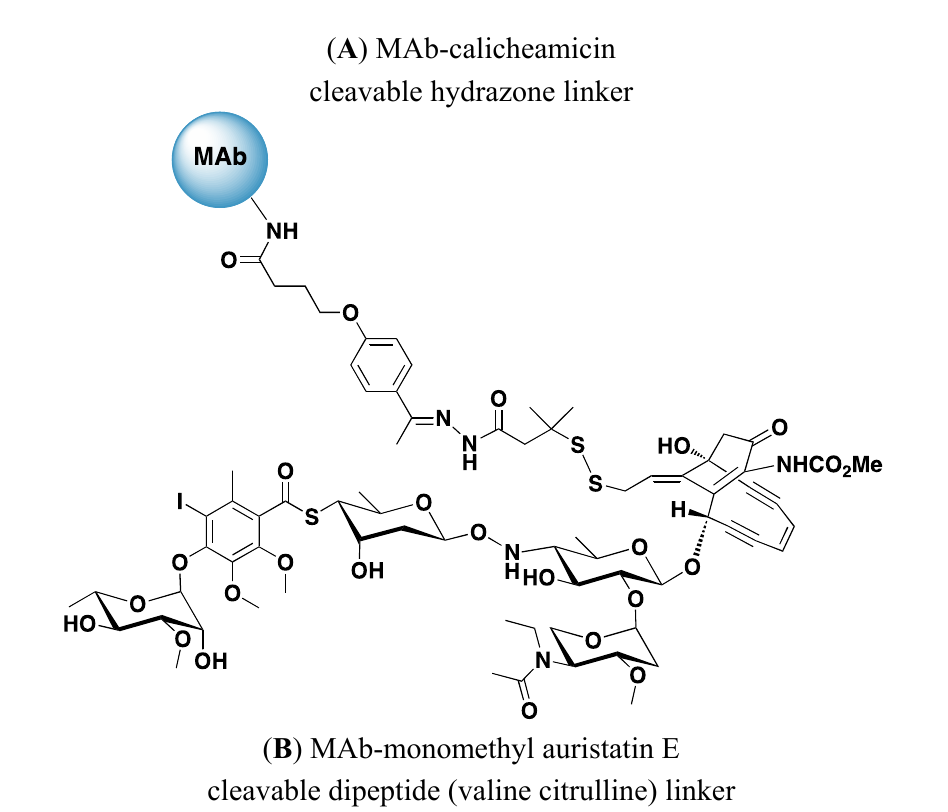
Figure 3. Structure of drugs and linkers used in ADCs under clinical